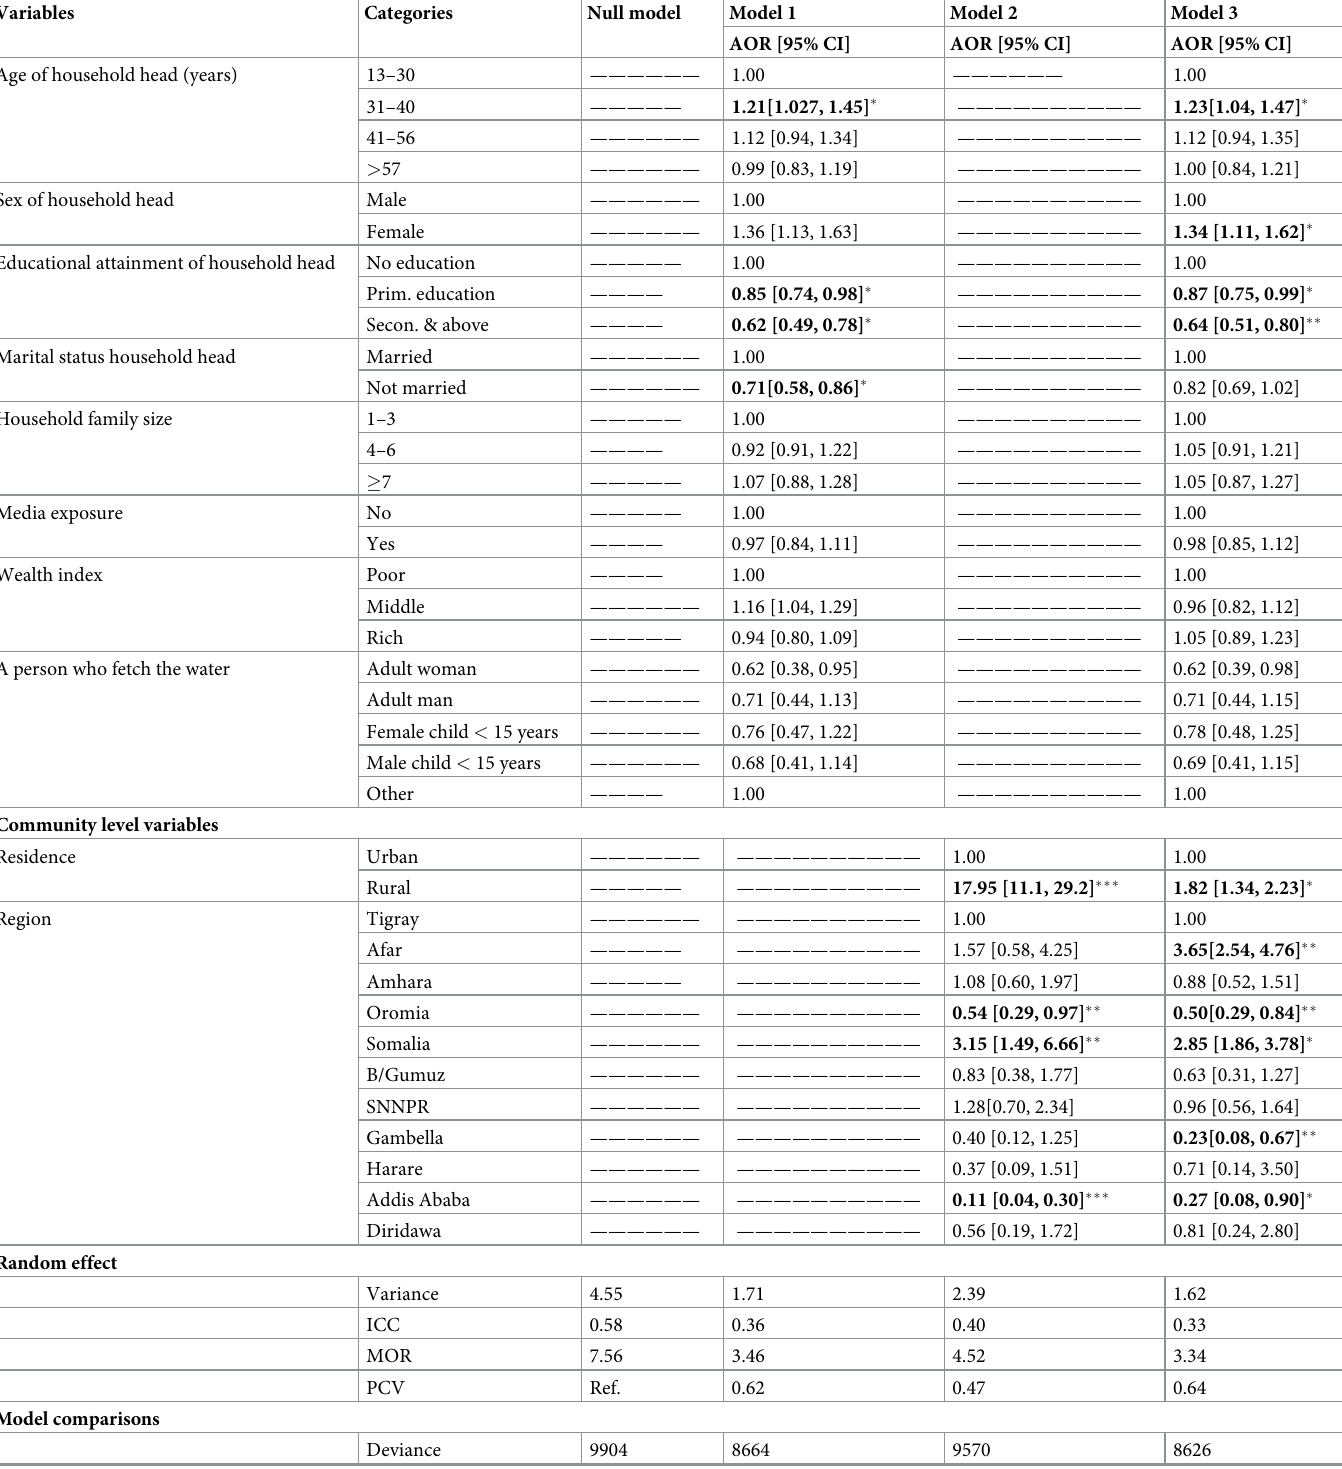
Table 2. Mixed effect analysis of limited access to drinking water services and its determinants among households in Ethiopia: Based on 2016